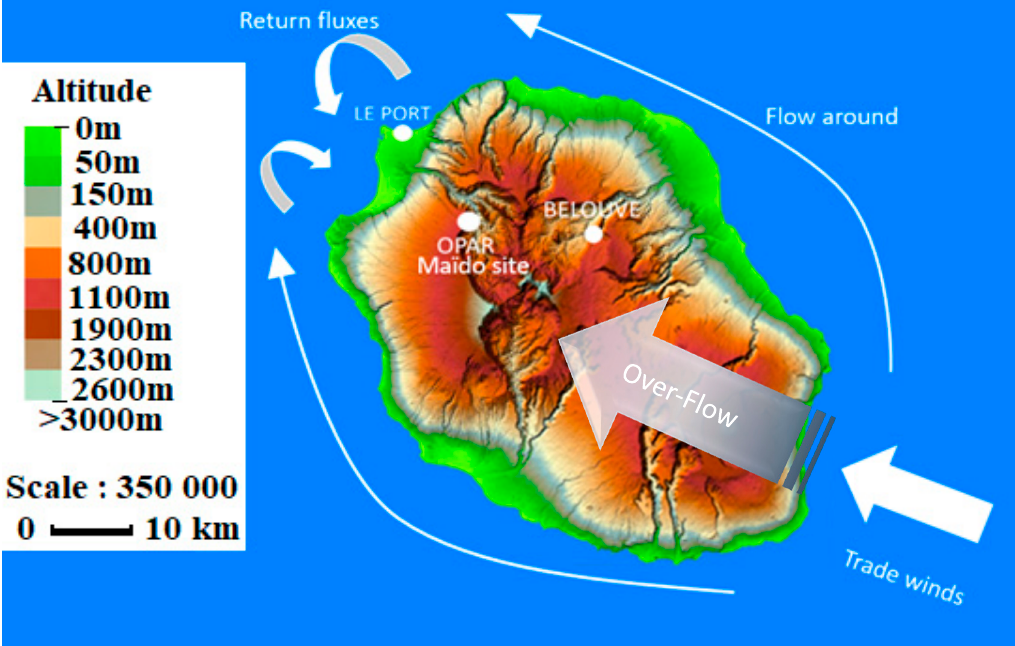
Figure 1. Situation map showing the location of the different measurement sites: Le Port, Bélouve, and Maïdo and wind patterns: flow around, over-flow and return flow.